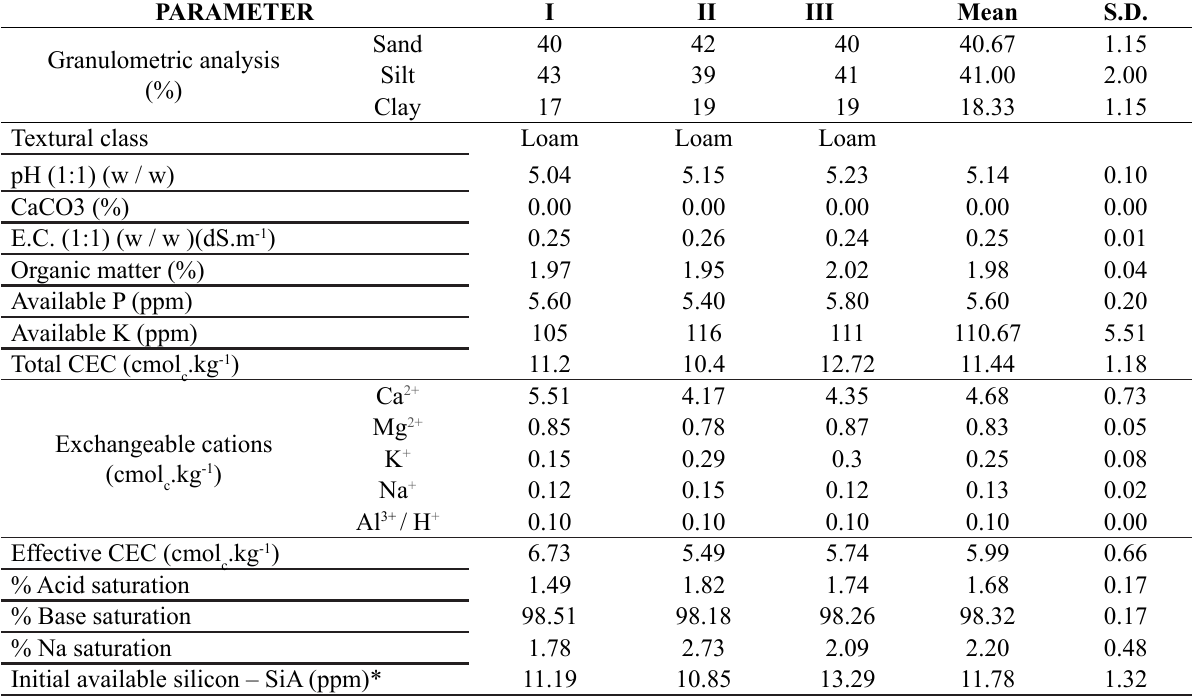
Table 1. Physical and chemical properties of the experimental topsoil collected from Aucayacu, Huanuco,